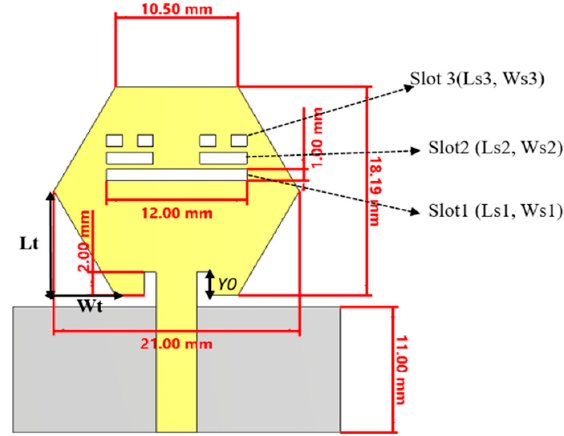
Figure 8 . Studied antenna-radiating element. Figure 8. Studied antenna-radiating element. The multifractal Cantor slots and the rectangular partial ground plane are described